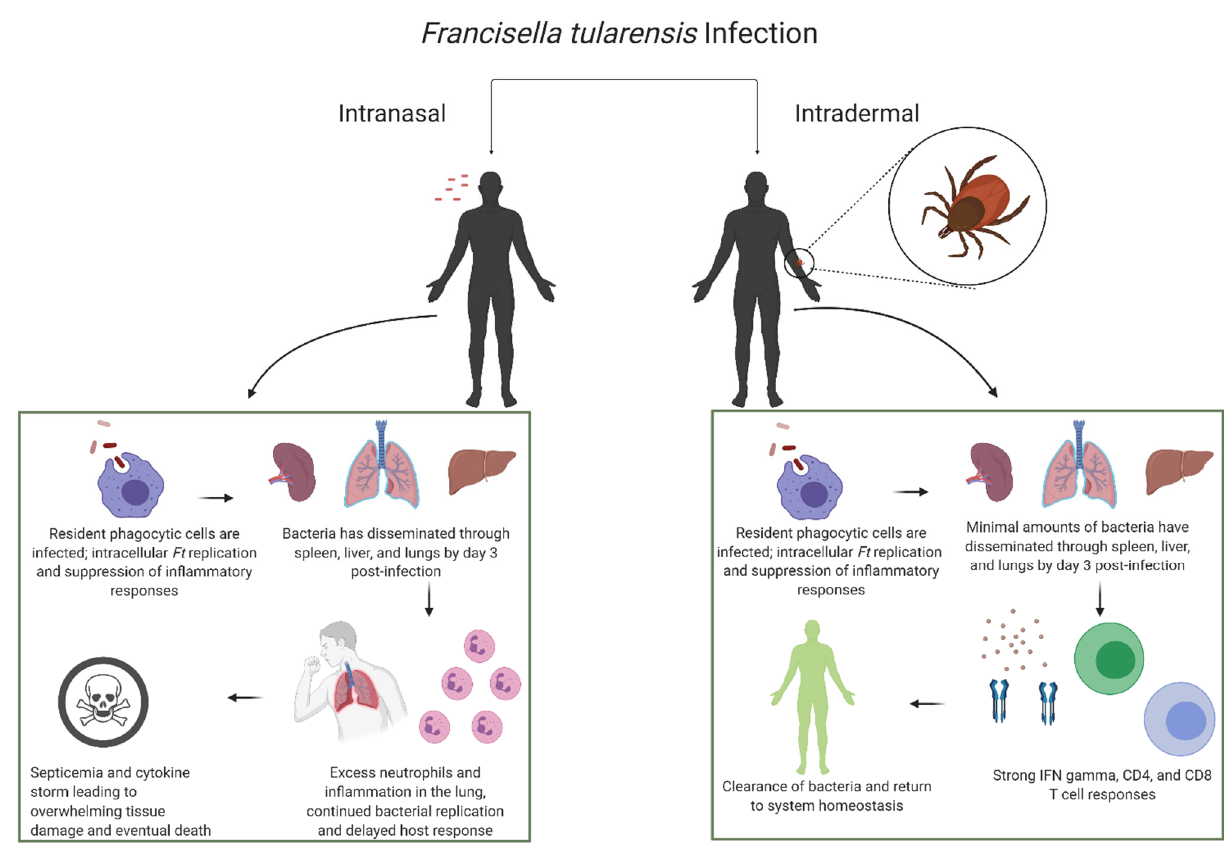
Figure 1. General characteristics of the host’s immune response during an untreated intranasal or intradermal infection with Francisella tularensis. Created with BioRender.com.